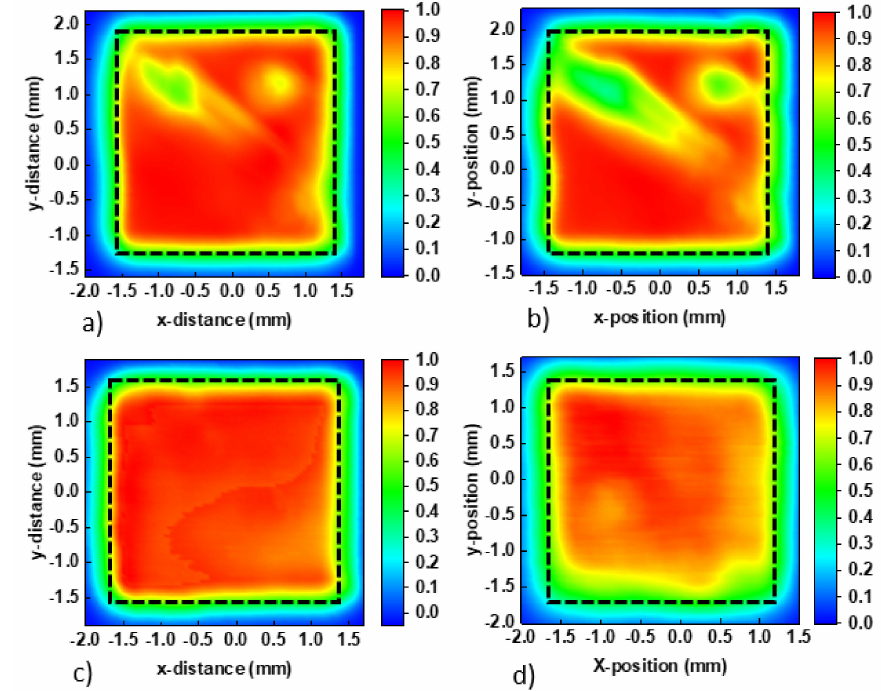
Figure 5. Photocurrent mapping of ( a ) fresh Cu:NiOx, ( b ) aged Cu:NiOx, ( c ) fresh β -alanine-treated Cu:NiOx, and ( d ) aged β -alanine-treated Cu:NiOx-based